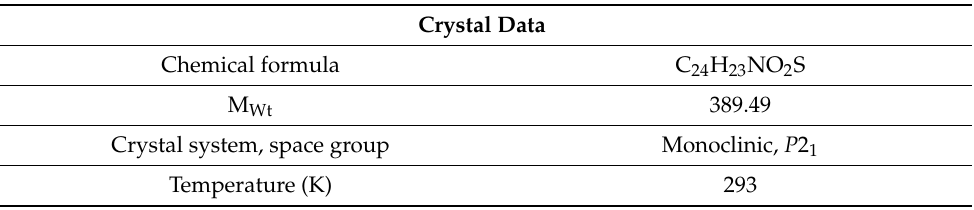
Table 1. Experimental details of aza-Michael product 3 .